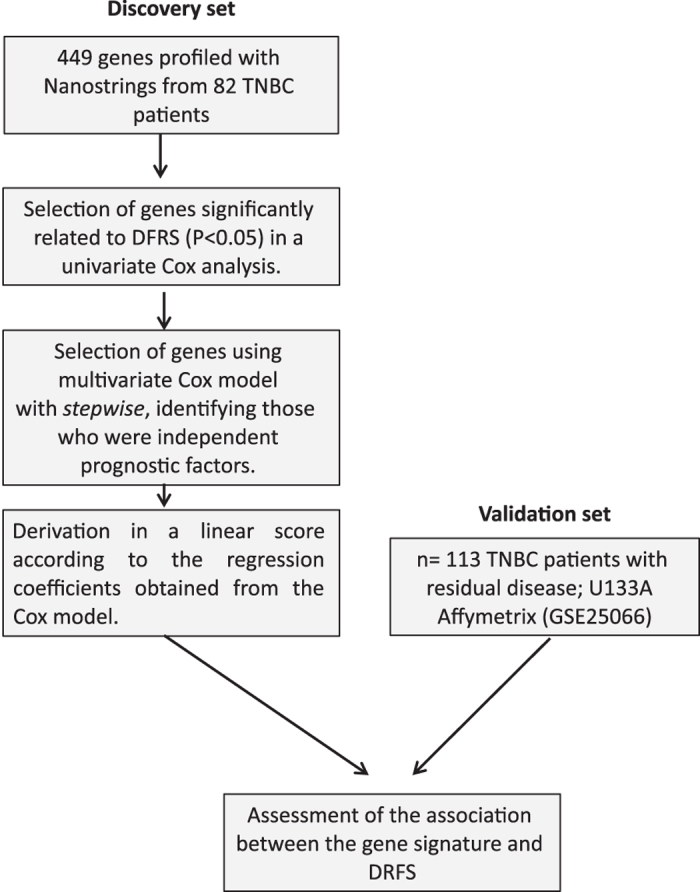
Overview of research design and workflow.